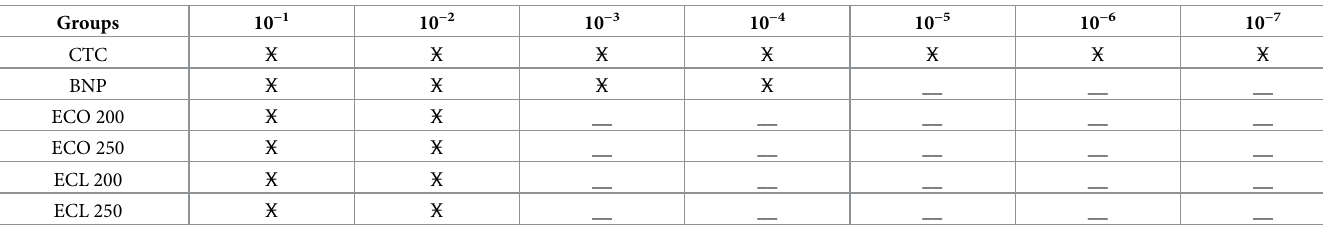
� ( Ӿ ) shows positive growth, (-) shows no